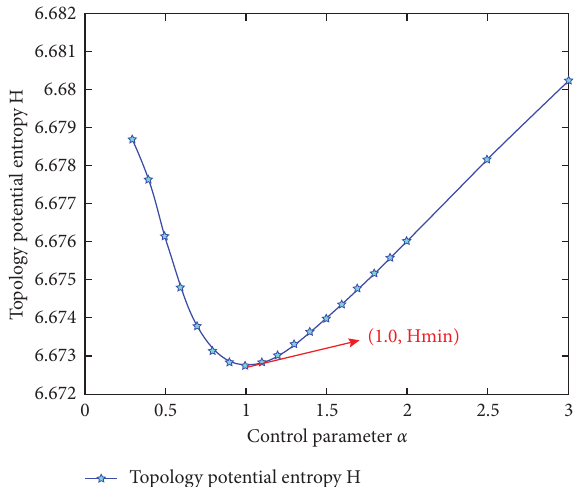
Figure 6: Topology potential entropy H changes with α .